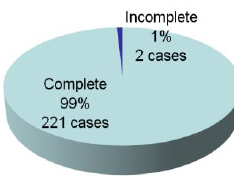
Fig. 1. Percentage of complete generated